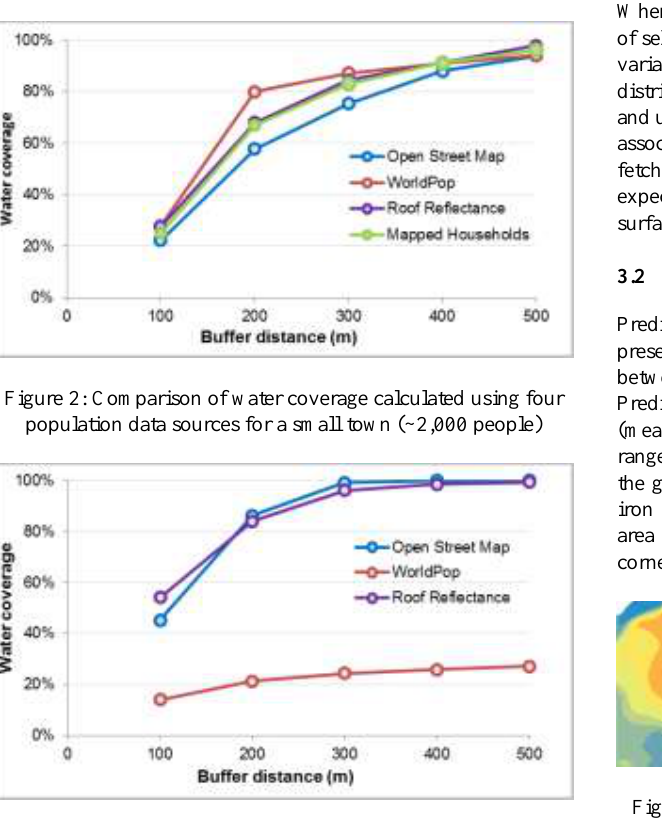
Figure 3: Comparison of water coverage calculated using three population data sources for a medium town (~5,000 people)